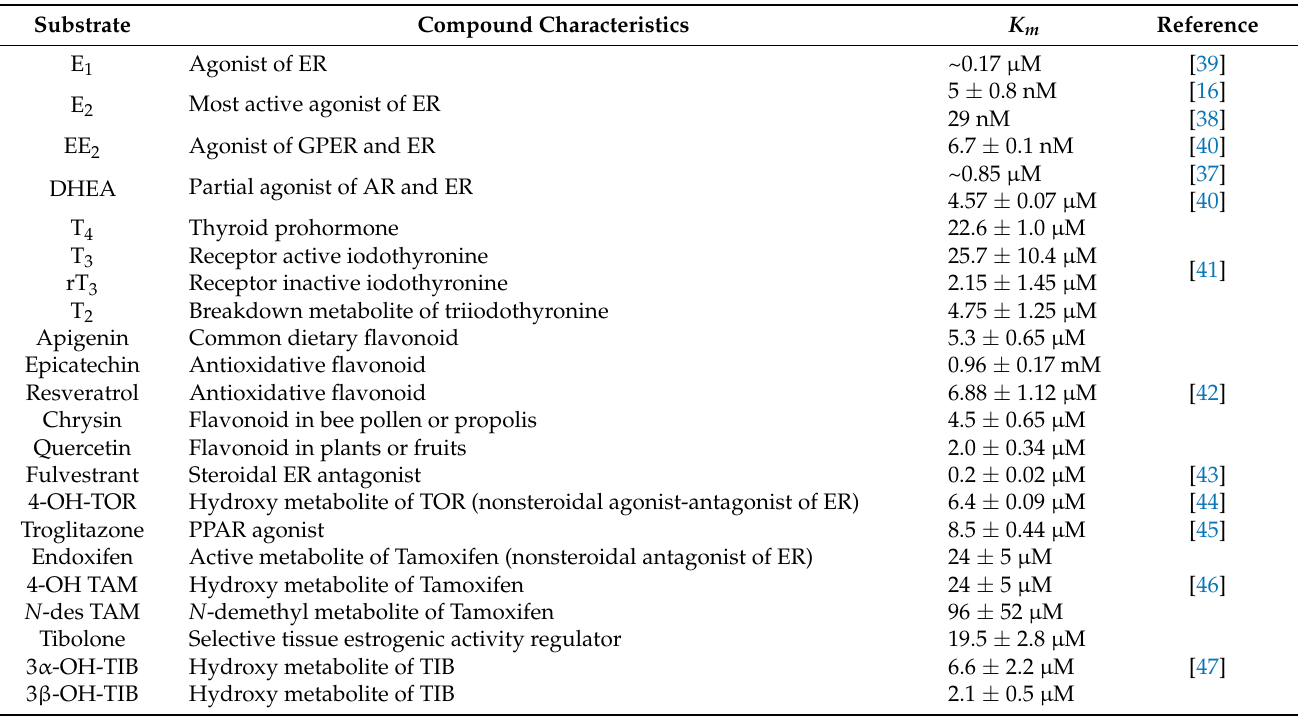
Figure 1. A schematic sulfation pathway of estrogens. STS, steroid sulfatase; PAPS, 3 (cid:48) -phosphoadenosine 5 (cid:48) -phosphosulfate; PAP, 3 (cid:48) -phosphoadenosine 5 (cid:48) -phosphate. Table 4. Substrates of